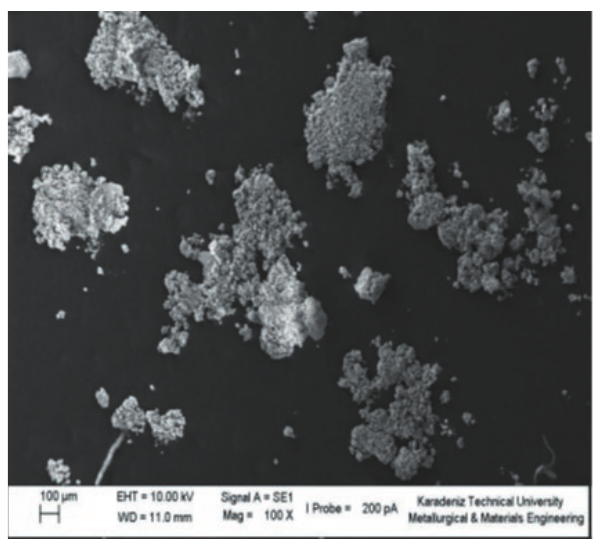
Figure 1. SEM images of ZnOTiO 2 NPs in dry form.